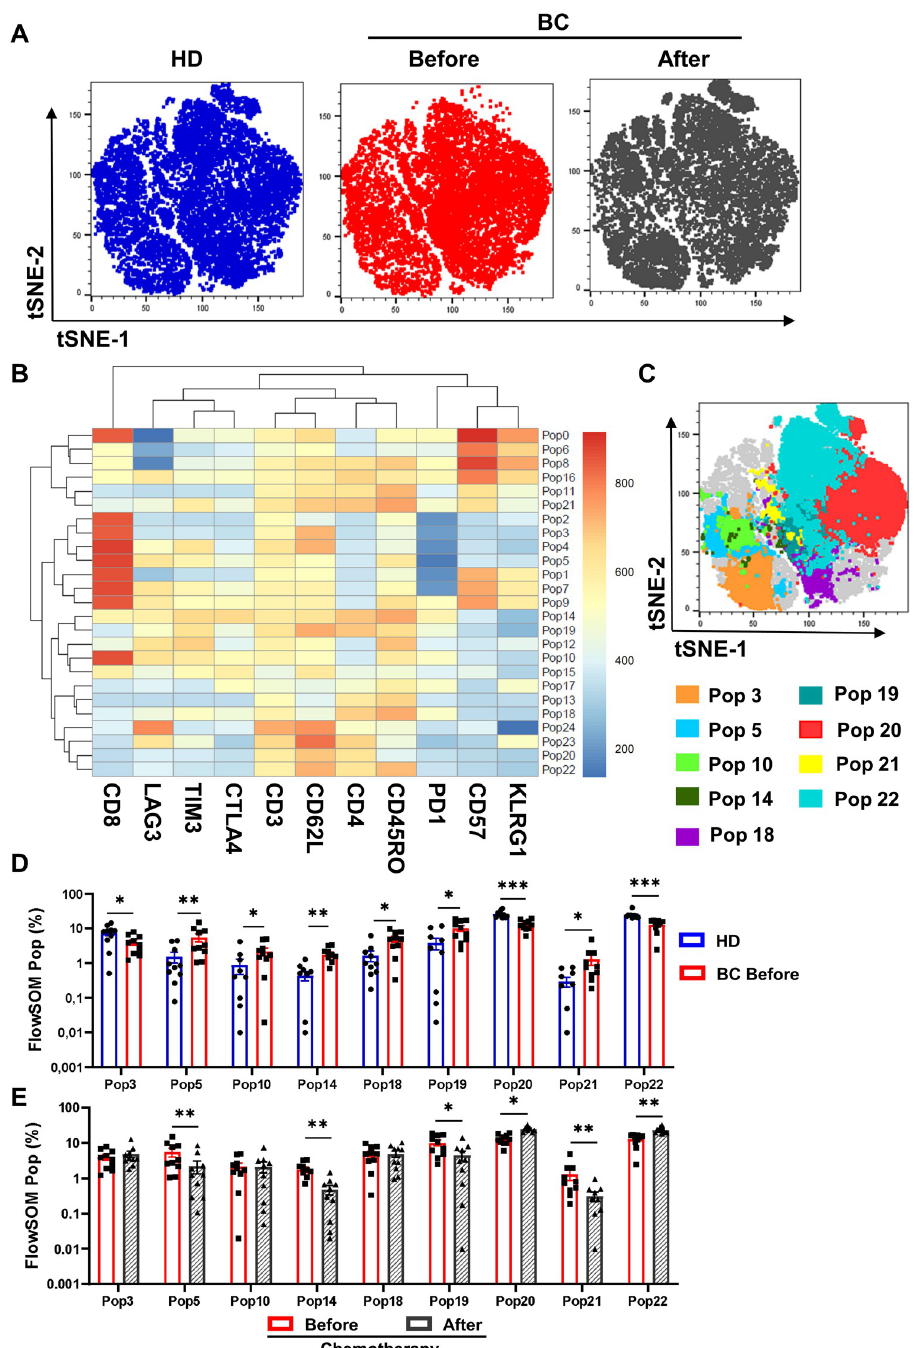
Fig 4. Identification of T-cell populations by FlowSOM. A . tSNE plots of concatenated samples of each group HD (blue), BC patients before chemotherapy (red), after chemotherapy (gray) B . Heat map of each marker in the 24 populations determined by FlowSOM. C . tSNE plots of concatenated samples with the relative location of the nine principal populations determined by FlowSOM that showed a difference among groups. D . Bar graph of relative cell frequency of nine populations determined by FlowSOM between HD (blue bars) and BC patients before chemotherapy (red bars). E . Bar graph of the relative cell frequency of nine populations determined by FlowSOM between BC patients before chemotherapy (red) and after chemotherapy (gray). A nonparametric t -test was performed with unpaired Mann-Whitney test data to compare HD and BC patient’s. A paired nonparametric Wilcoxon test to compare BC patients before and after chemotherapy. Data presented as means ± SEM ( ��� p < 0.001; �� p < 0.01; � p <